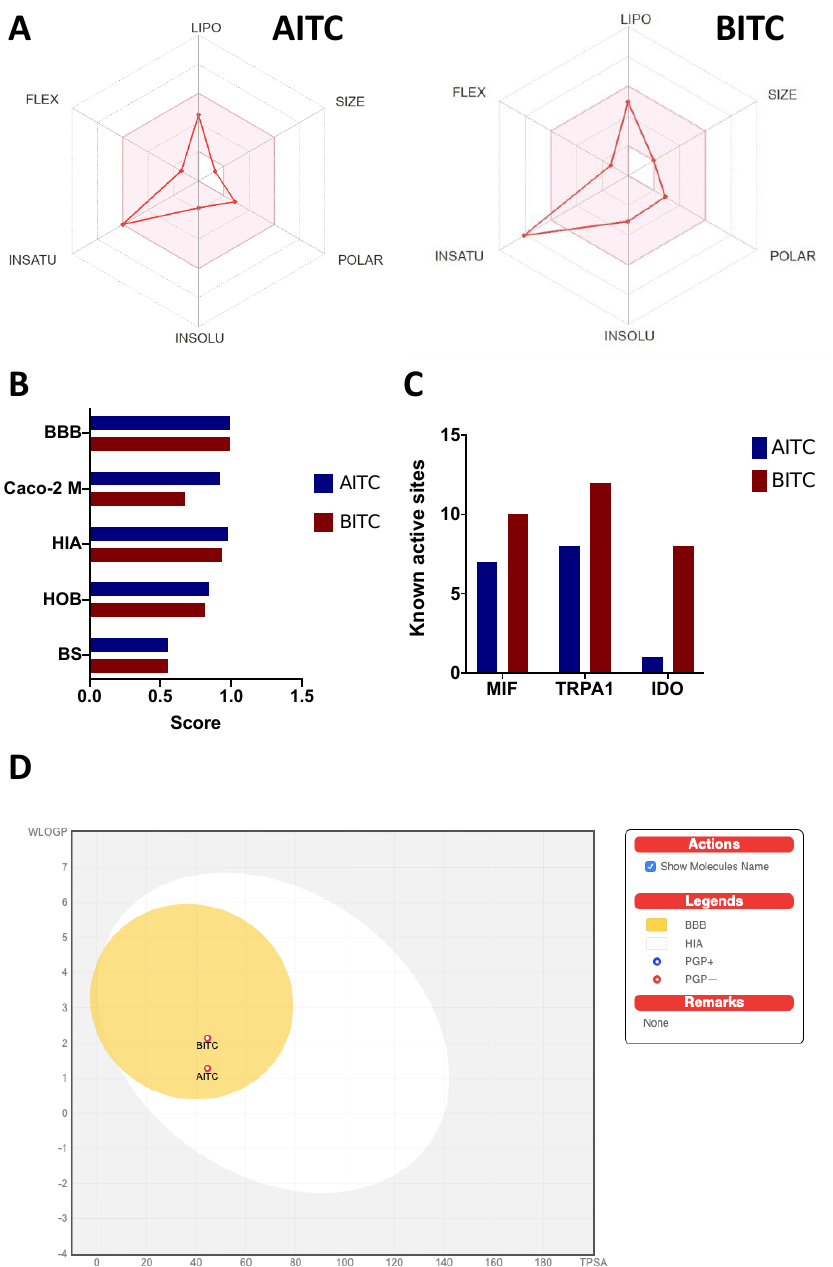
Figure 8. In silico prediction of bioavailability scores of AITC and BITC. Overall bioavailability plots of ( A ) AITC and BITC; ( B ) calculated scores of blood–brain barrier (BBB) permeability, Caco-2 cell model (Caco-2 M) permeability, human intestinal absorption (HIA), human oral bioavailability (HOB), and bioavailability score (BS) of AITC and BITC; ( C ) prediction of the best drug-targeting abilities of AITC and BITC based on their known active sites for macrophage migration inhibitor factor (MIF), transient receptor potential cation channel subfamily A member 1 (TRPA1), and indoleamine-2,3-dioxygenase (IDO); and ( D ) “Boiled Egg” model of AITC and BITC absorption plotting the atomistic interpretation of the fragmental system of Wildman and Crippen for lipophilicity (WLOGP) and the topological polar surface area for apparent polarity (TPSA). The colored zone in Figure 7A shows the suitable physicochemical space for HOB (lipophilicity: − 0.7 to 5; size: 150 – 500 g/mol; polarity: 20 – 130 Å 2 ; insolubility: − 6 to 0; unsaturation: 0.25 – 1; flexibility: 0 – 9 rotatable bonds). FLEX: flexibility; INSATU: unsaturation; INSOLU: insolubility; LIPO: lipophilicity; POLAR: polarity; PGP: